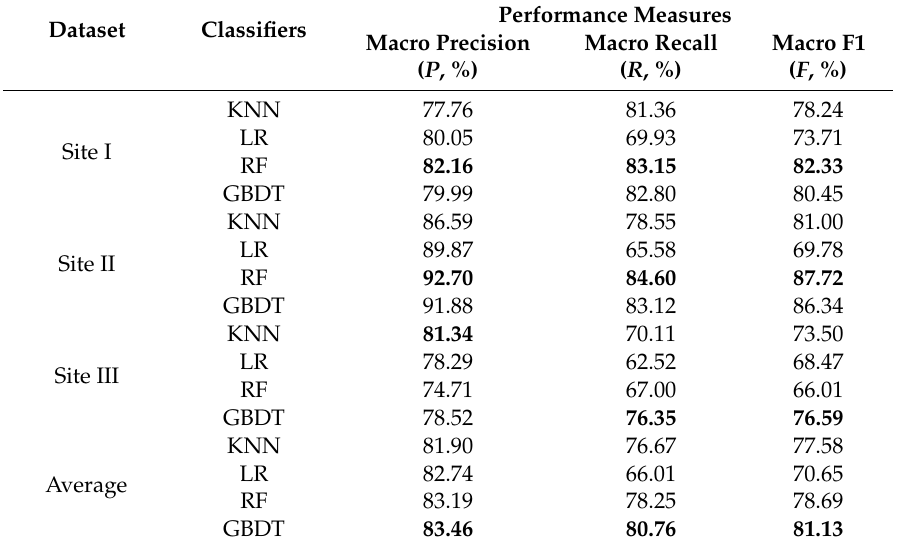
Table 4. Classification performance for the di ff erent classifiers (feature set = F 0 , class distribution = unbalanced, R = 1.5 m). Three performance measures are shown in this table. P denotes the macro precision, R denotes the macro recall, and F denotes the macro F1. Bold denotes best results for each performance metric in each test